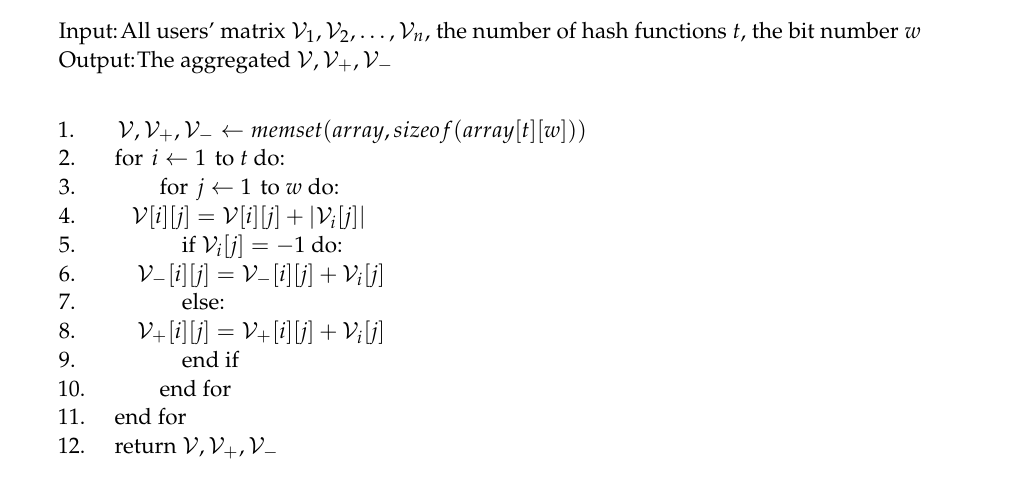
Algorithm 4: MDLDP-Aggregate